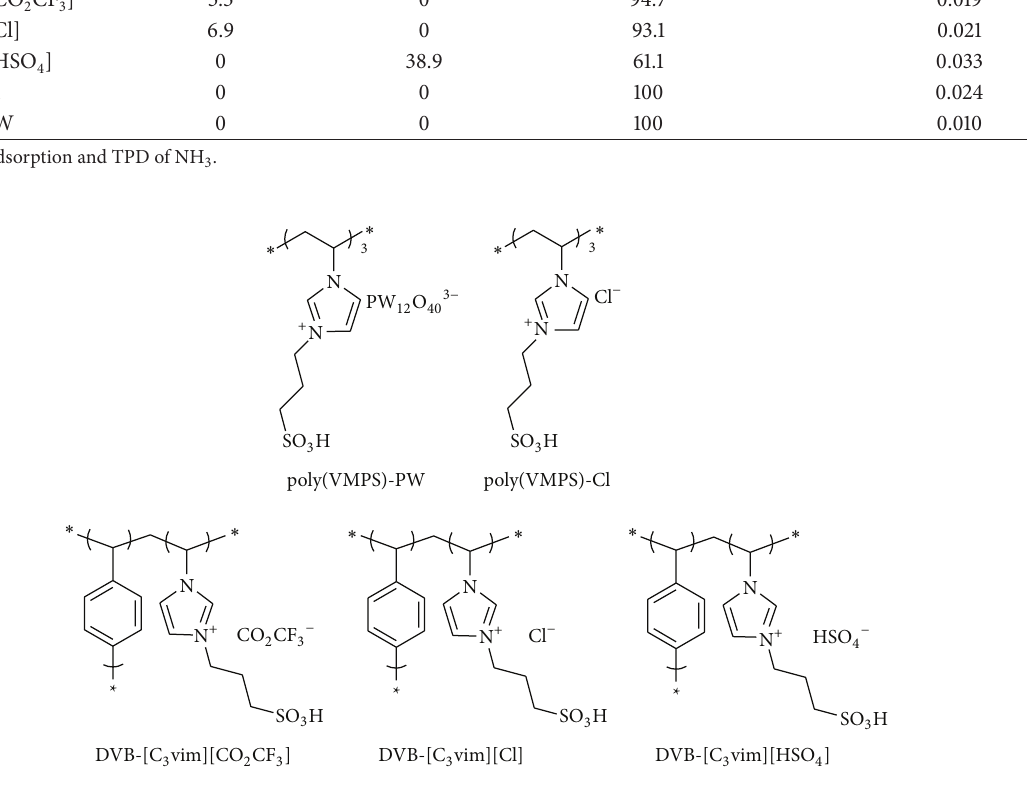
Figure 1: General structures of the prepared –SO 3 H functionalized